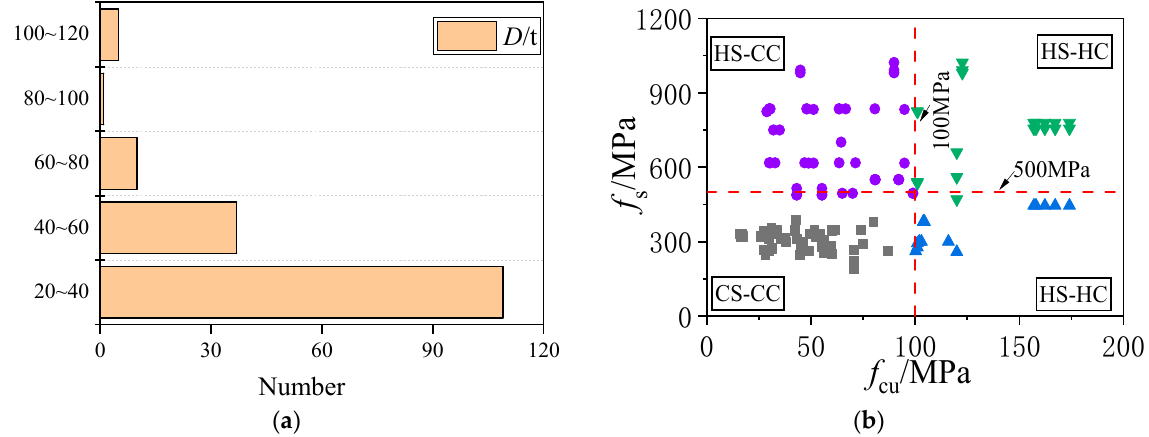
Figure 4. Distribution of test data of CFST stub columns. ( a ) Diameter-to-thickness ratio distribution of steel tube. ( b ) Different material matches distribution.